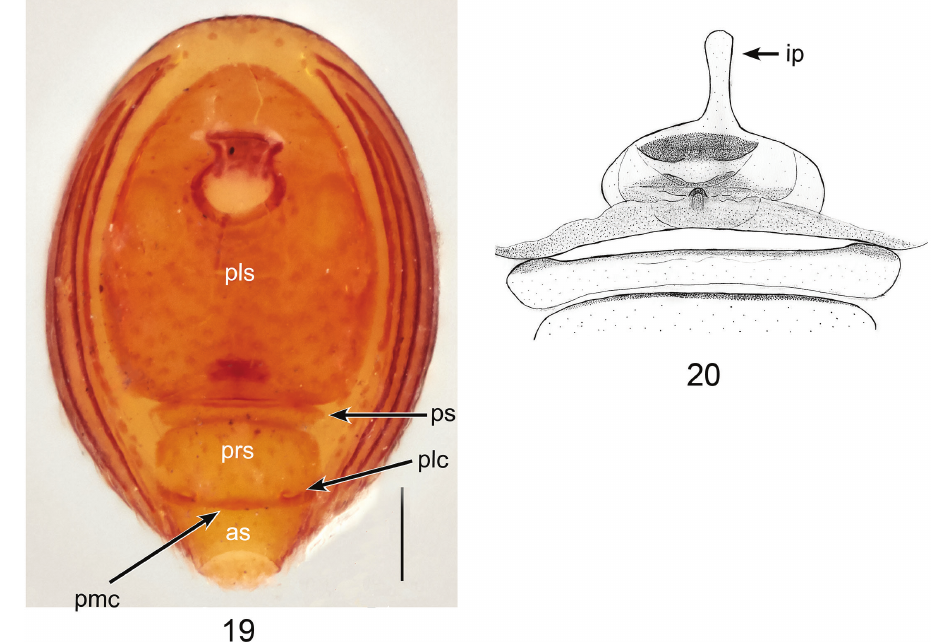
Figures 19, 20. Ablemma contrita sp. n., female. 19 Abdomen, ventral view. 20 Schematic illustration of genitalia, dorsal view. Scale bar: 0.1